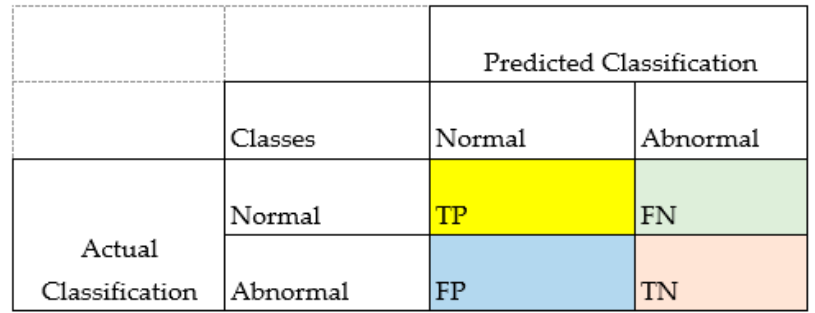
Figure 5. The confusing matrix this study used.